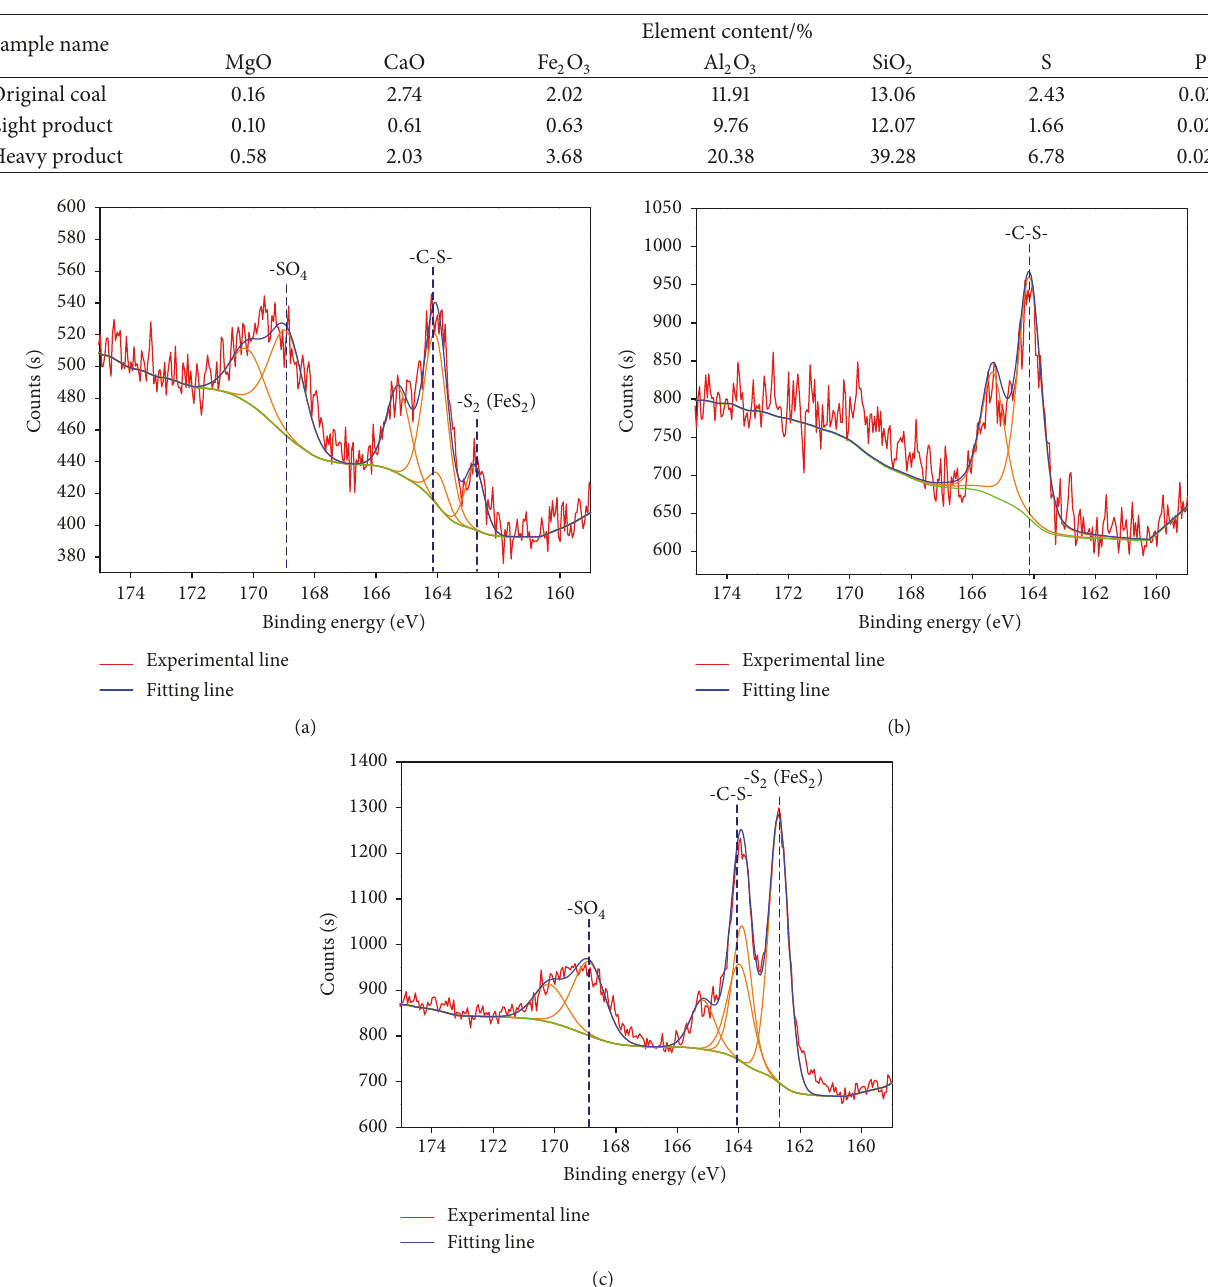
Table 3: Elemental composition of different samples.